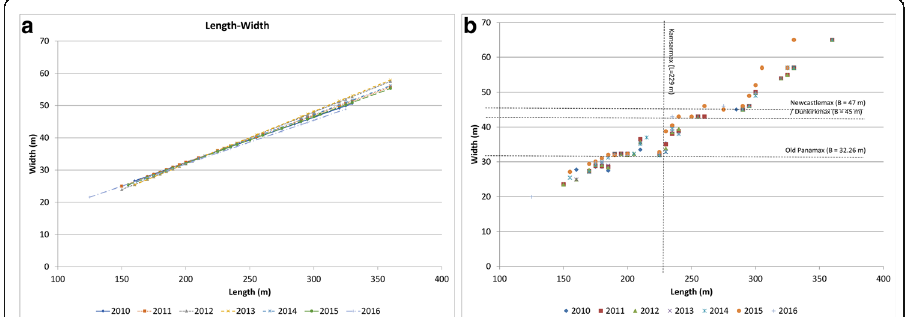
Fig. 5 OLS estimated lines for Width based on Length (left) and the pattern of averages for Width against Length